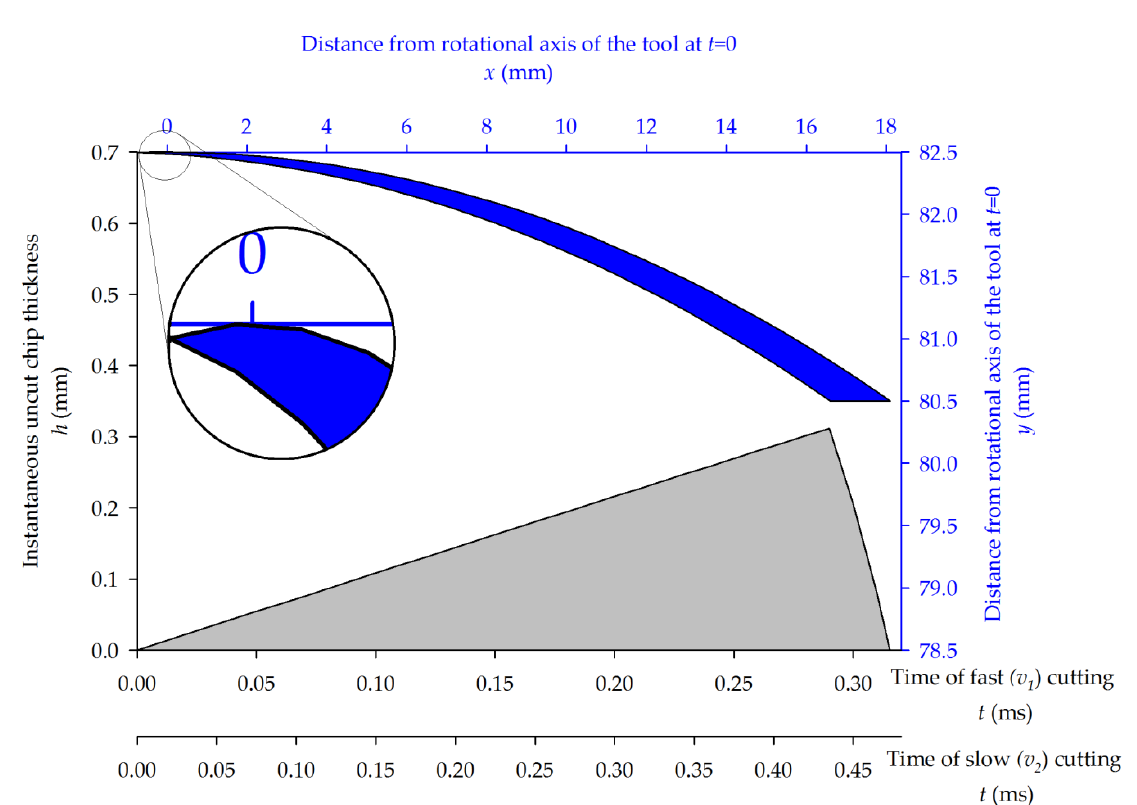
Figure 9. Shape of the uncut chip (blue) given in two dimensions and its calculated instantaneous thickness (gray).